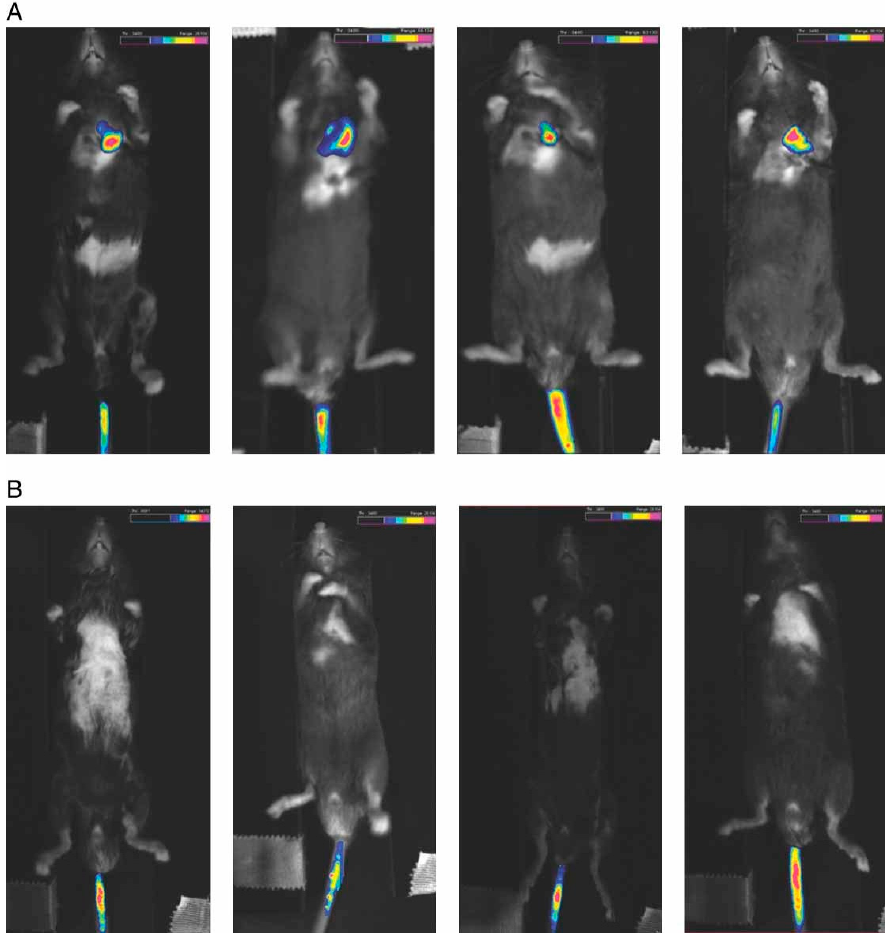
Figure 3. Non-invasive in vivo trafficking of MNB/PEI/DNA nanostructures 2 h after systemic administration. The fluorescent image (pseudocolor) was overlaid on the photographic image. The intensity of fluorescent signal from MNB/Oregon green 488 labeled-PEI/DNA was stronger in the left chest in group with magnet ( A ) compared to the group without magnet ( B ). Adapted with permission from [48].